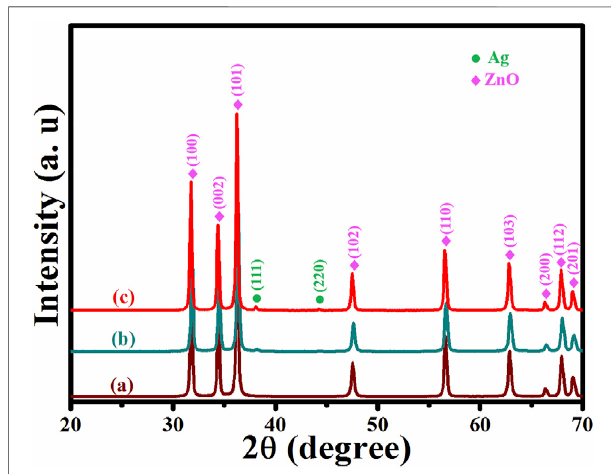
FIGURE 1 | XRD patterns of (A) ZnO, (B) Ag/ZnO, (C) Ag/ZnO@N- cabon.